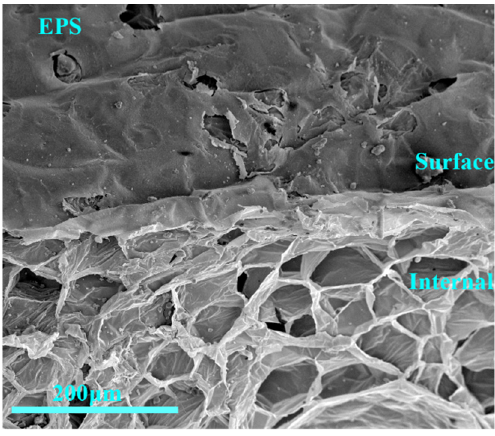
Figure 6. Surface and internal microstructure of untreated EPS.